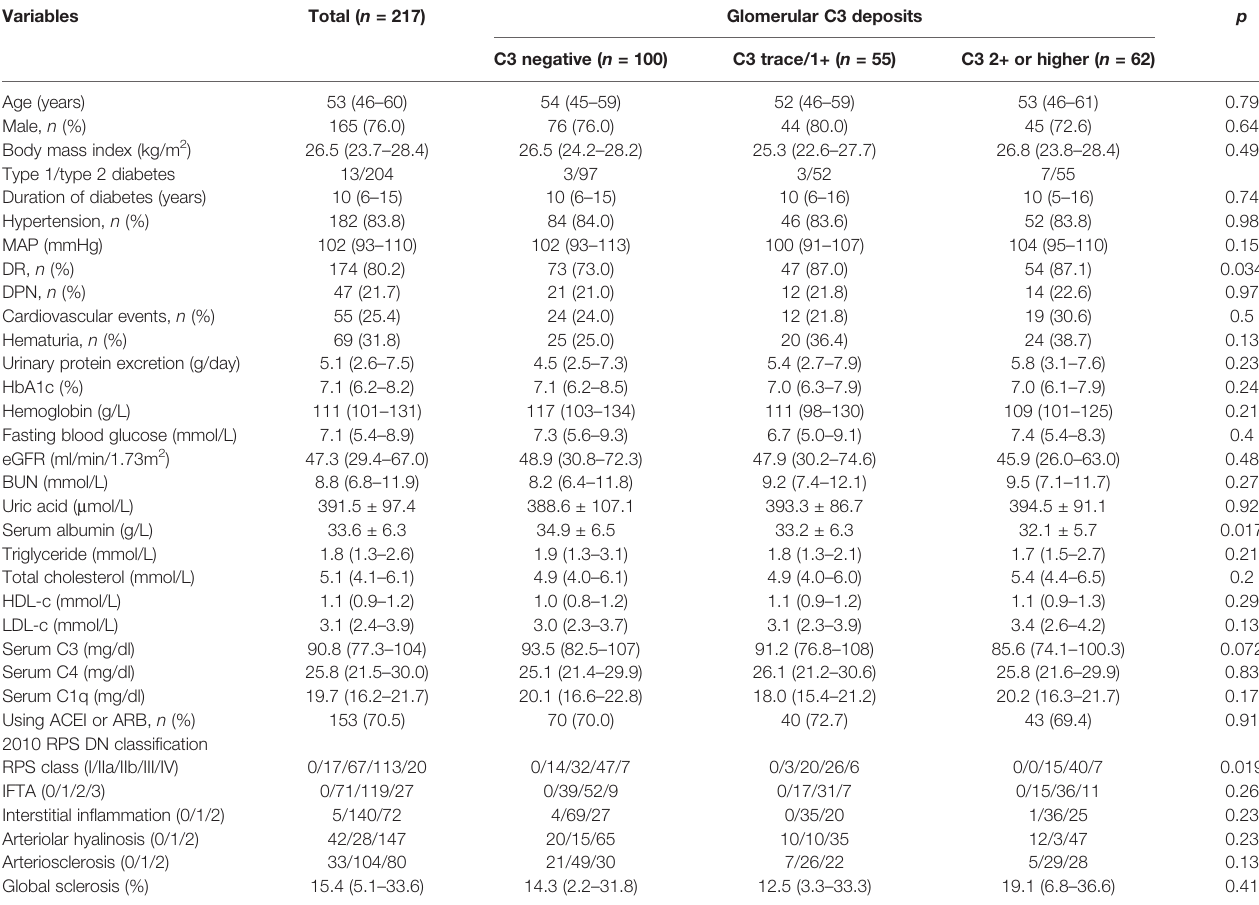
TABLE 1 | Baseline characteristics of diabetic nephropathy strati fi ed by glomerular C3 deposits. Variables Total ( n = 217) Glomerular C3